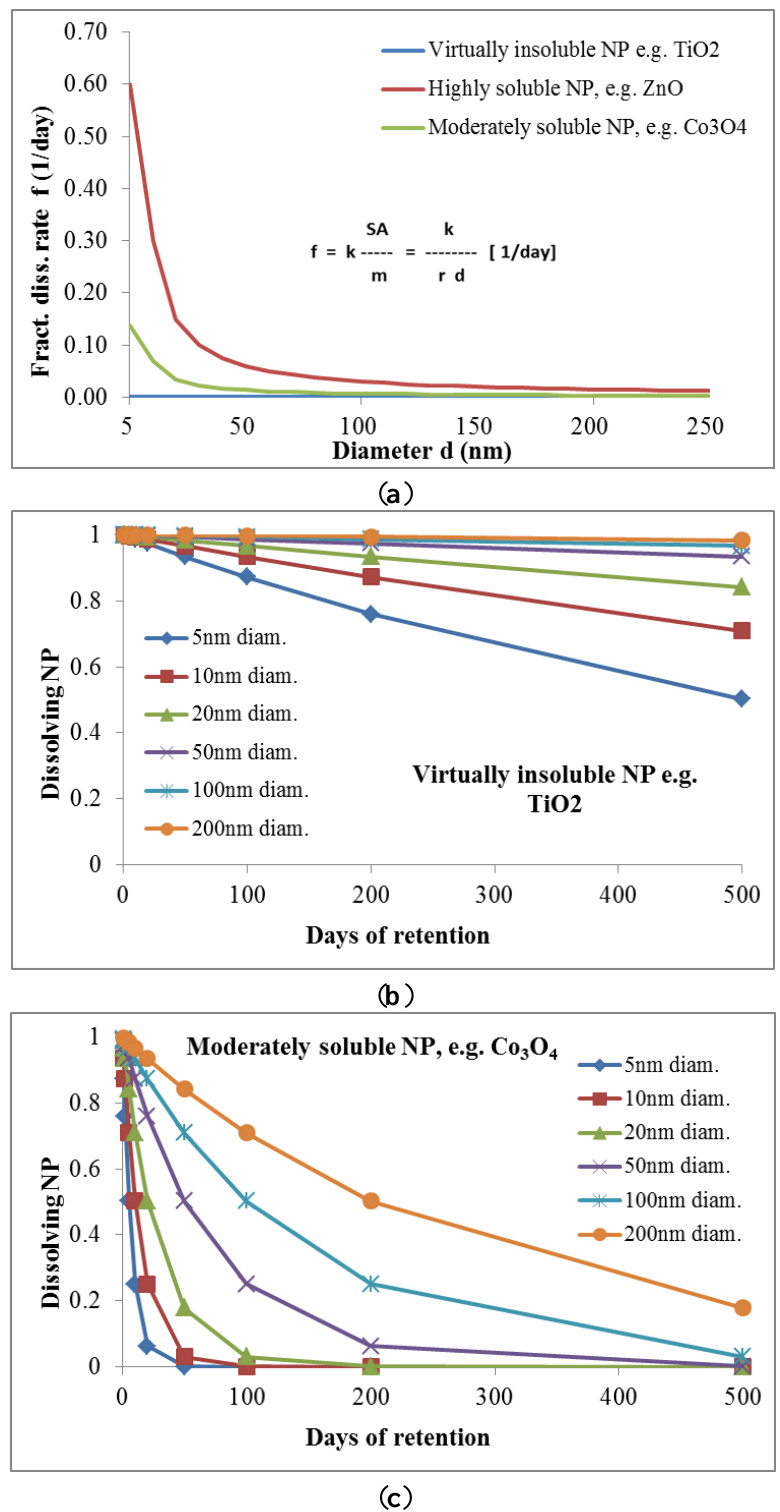
Figure 6. Weighting factor 6 ( w PC,6 ) is a function of the dissolution rate of the NP. Panel a : fractional mass loss of differently soluble NPs over NP diameters ranging from 5 to 250 nm; Panels b – d give the fractional NP mass losses over time for different NP sizes of virtually insoluble (b), moderately soluble (c) and highly soluble NPs